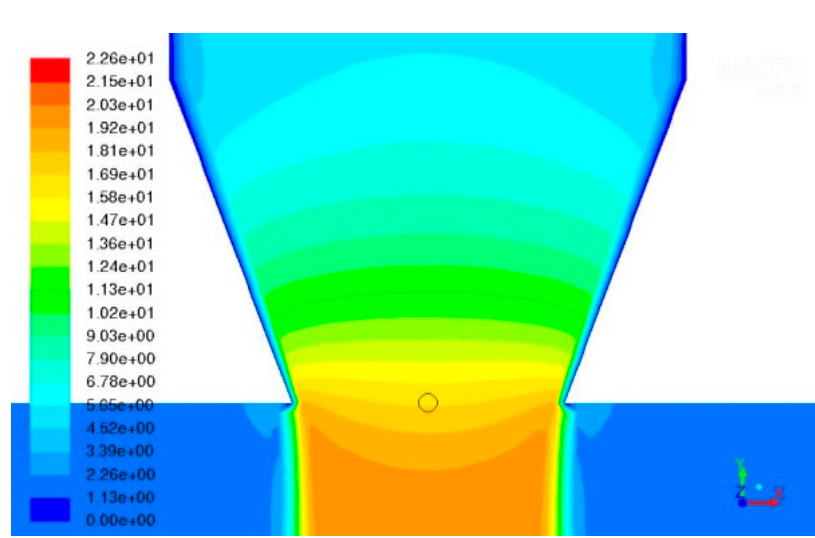
Figure 5. Velocity vectors (magnitude).